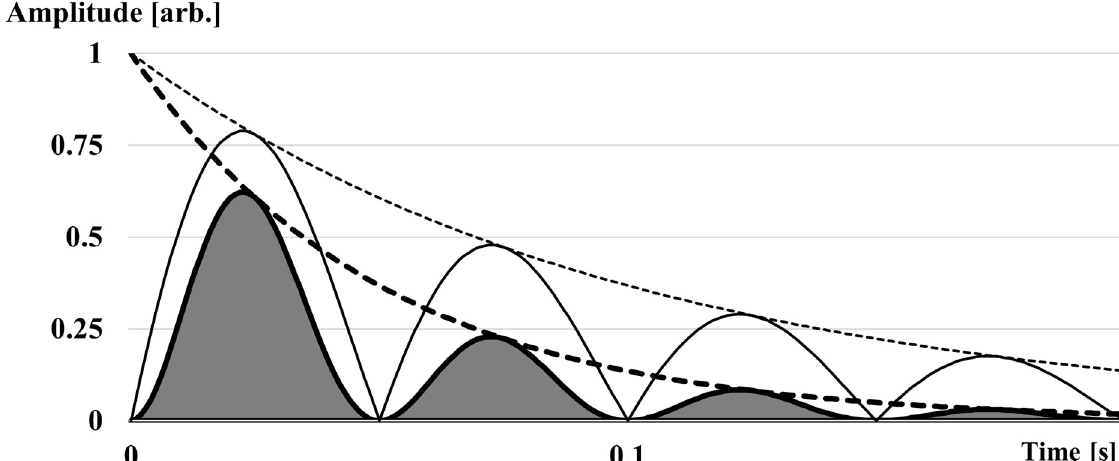
Fig 2. Illustration of damped oscillations. Schematic representation of the model with a dominant vibration frequency of 10 Hz and a damping coefficient c = 20s -1 . The damped absolute signal (thin solid line) with its exponential decay (thin dashed line) and the signal power (squared signal; thick solid line) with its exponential decay (thick dashed line) is illustrated. The grey area indicates the absorbed energy of the signal (sum of squared absolute amplitude or power-time integral).